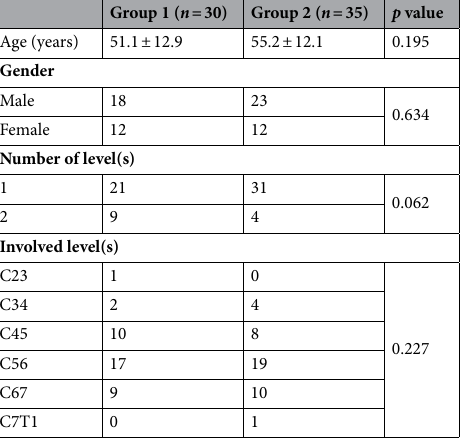
Table 1. Comparison of demographic and surgical data of both groups. All continuous values are in mean ± standard deviation. Involved level(s) include each level for multilevel surgery. P value below 0.05 is considered statistically significant. PEEK,